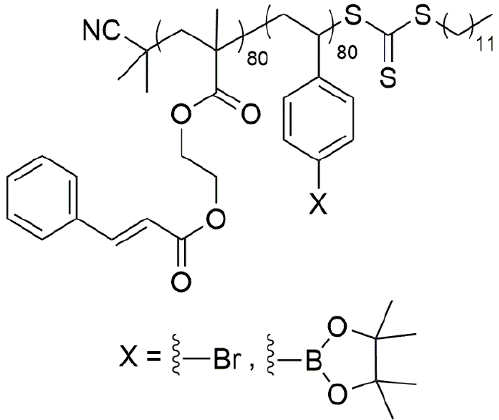
Figure 1. Diblock copolymer for coating